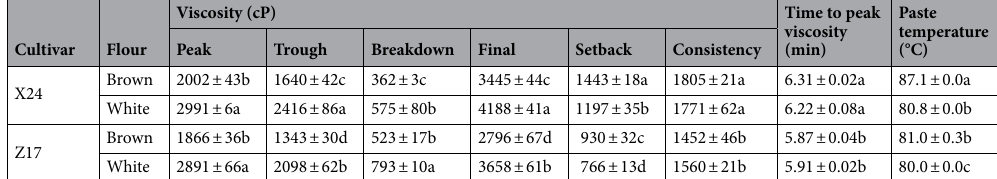
Table 2. Paste properties of brown and white rice flours processed from two rice cultivars, Xiangzaoxian 24 (X24) and Zhongjiazao 17 (Z17). Data are mean ± SE ( n = 3). Within a column, data sharing the same lowercase letters are not significantly different at the 0.05 probability